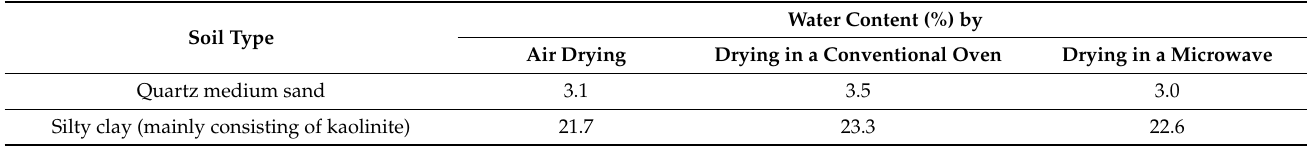
Table 3. Results of the water content